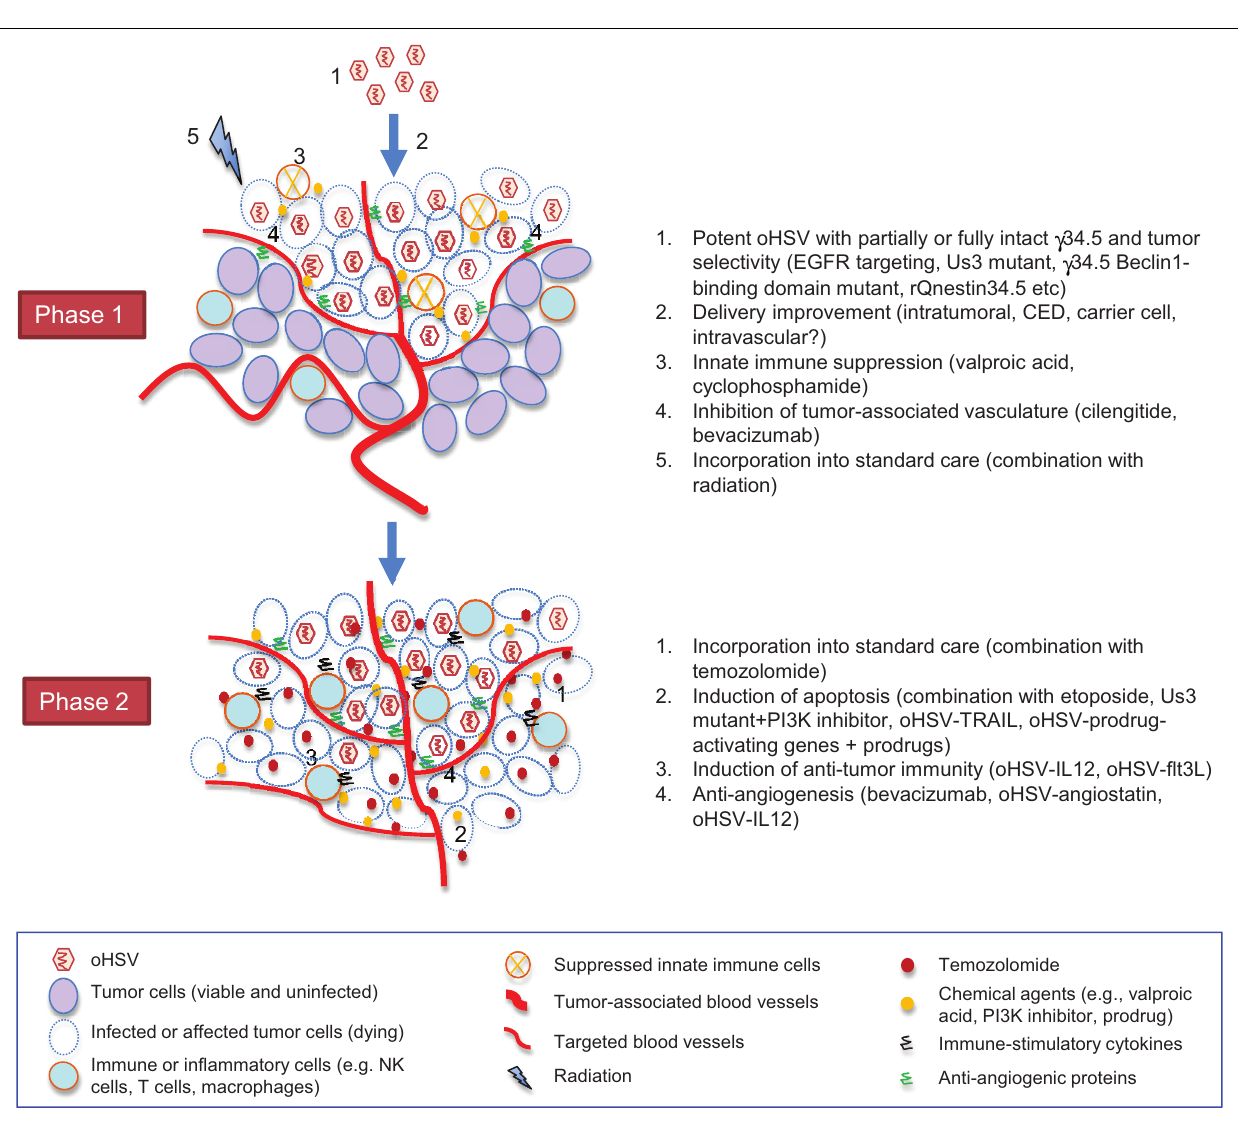
FIGURE 1 | Two-phasic process that oHSV-based strategies go through toward successful GBM tumor elimination. For each phase, representative interventional approaches that we discussed in the text are listed on the right.